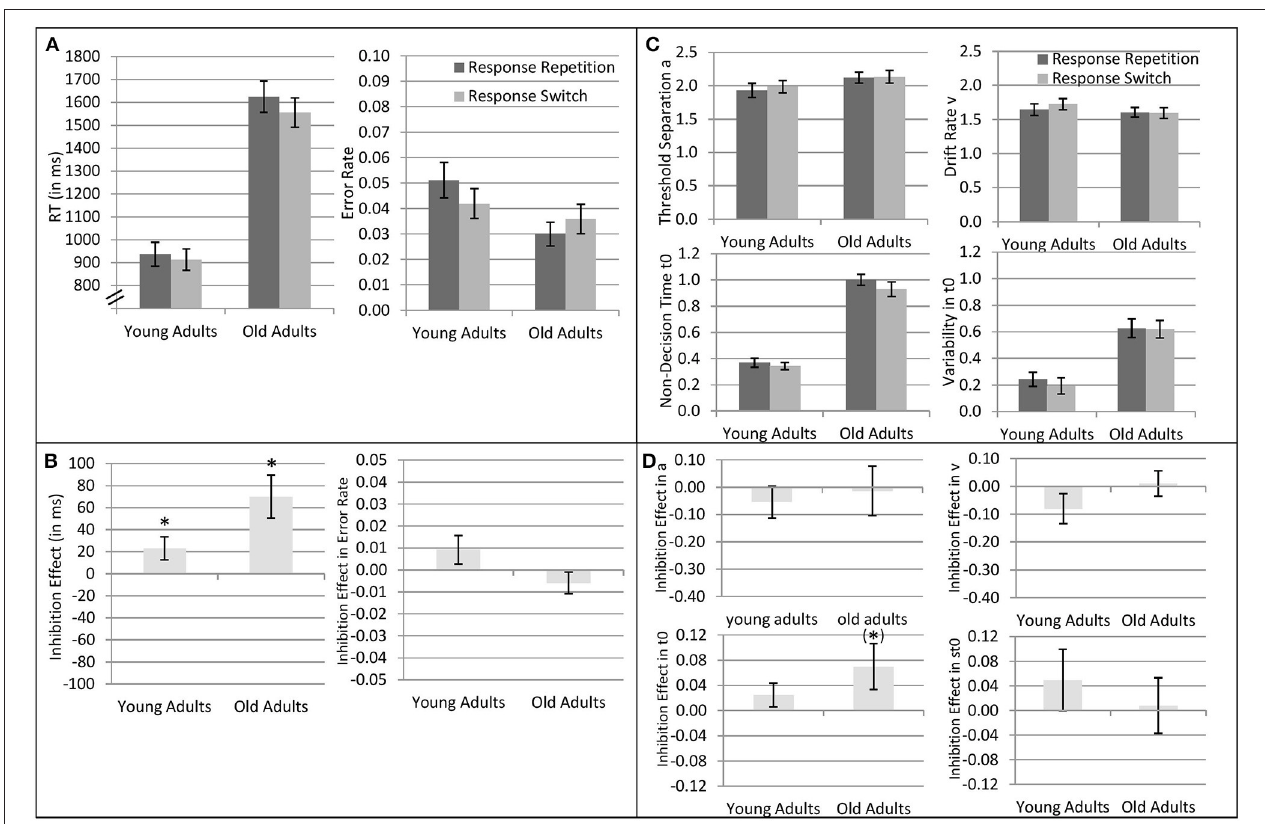
FIGURE 4 | Analysis of response inhibition (response repetitions vs. response switches from trial n − 1 to n ) in young adults (18–26 years; N = 22) and older adults (64–79 years; N = 22). (A) Mean reaction times and mean error rates in response repetitions and switches. (B) Mean response inhibition effect (repetition-switch) in reaction times and error rates. (C) Diffusion model parameters threshold separation a , drift rate ν , non-decision time t 0 , and variability of non-decision time s t 0 , separately for response repetitions and switches, and young and older adults. Units on the y-axis represent the untransformed values as obtained by the fast-dm software ( Voss and Voss, 2007; diffusion coefficient = 1.0). The units represent amount of evidence for a ; evidence per time for ν ; time (in s) for t 0 and s t 0 . (D) Mean response inhibition effect (repetition-switch) in diffusion model parameters. Error bars indicate 1 standard error of mean. * indicates significant response inhibition effect, i.e., p < 0.05 for the two-tailed t -test comparing response repetition and response switch within each age group; (*) indicates p < 0.10 for the two-tailed t